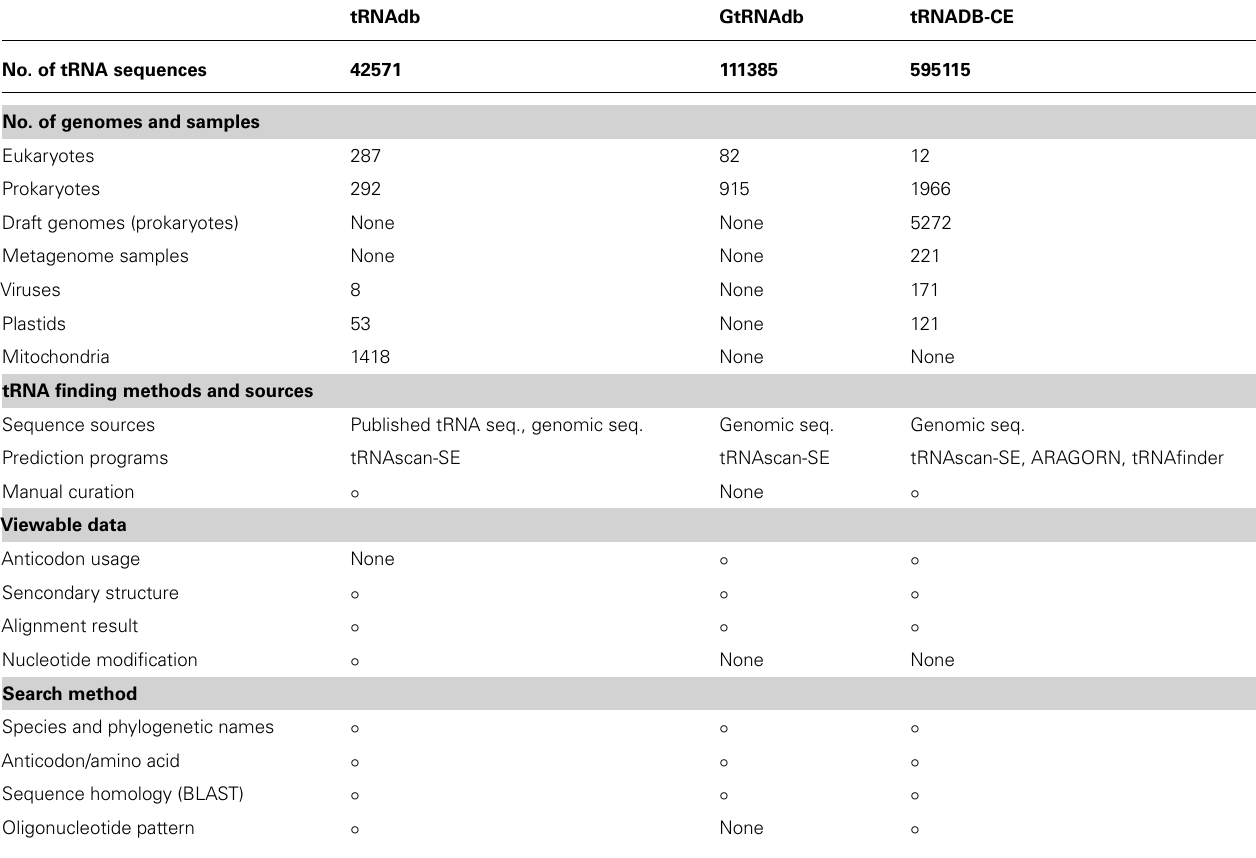
Table 1 | Comparison of registered data and functions between databases (at March,